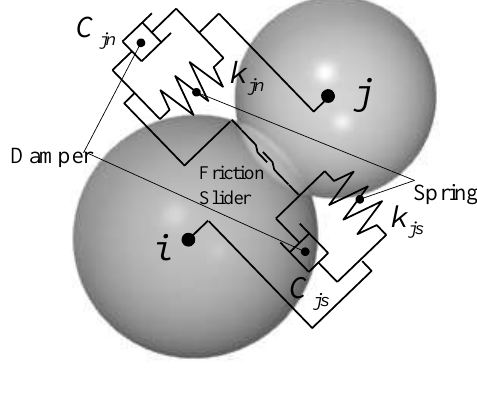
Figure 2. Model for